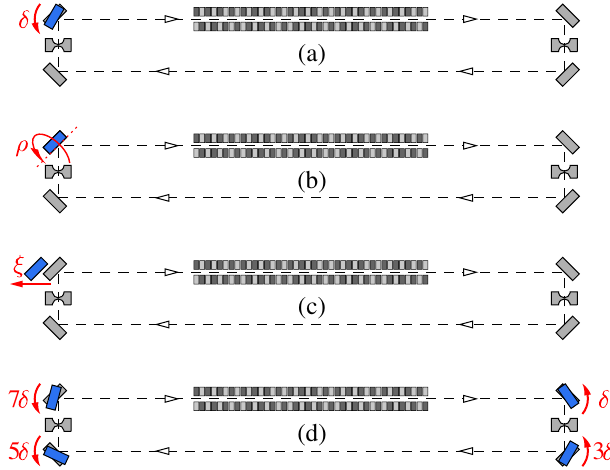
FIG. 7. Schematics of crystal misalignment scenarios. One- crystal misalignment: (a) yaw angle δ , (b) roll angle ρ , and (c) position ξ for crystal C 4 . Systematic multi-crystal misalign- ment: (d) yaw angles δ , 3 δ , 5 δ , and 7 δ for crystals C 1 – C 4 , respectively.